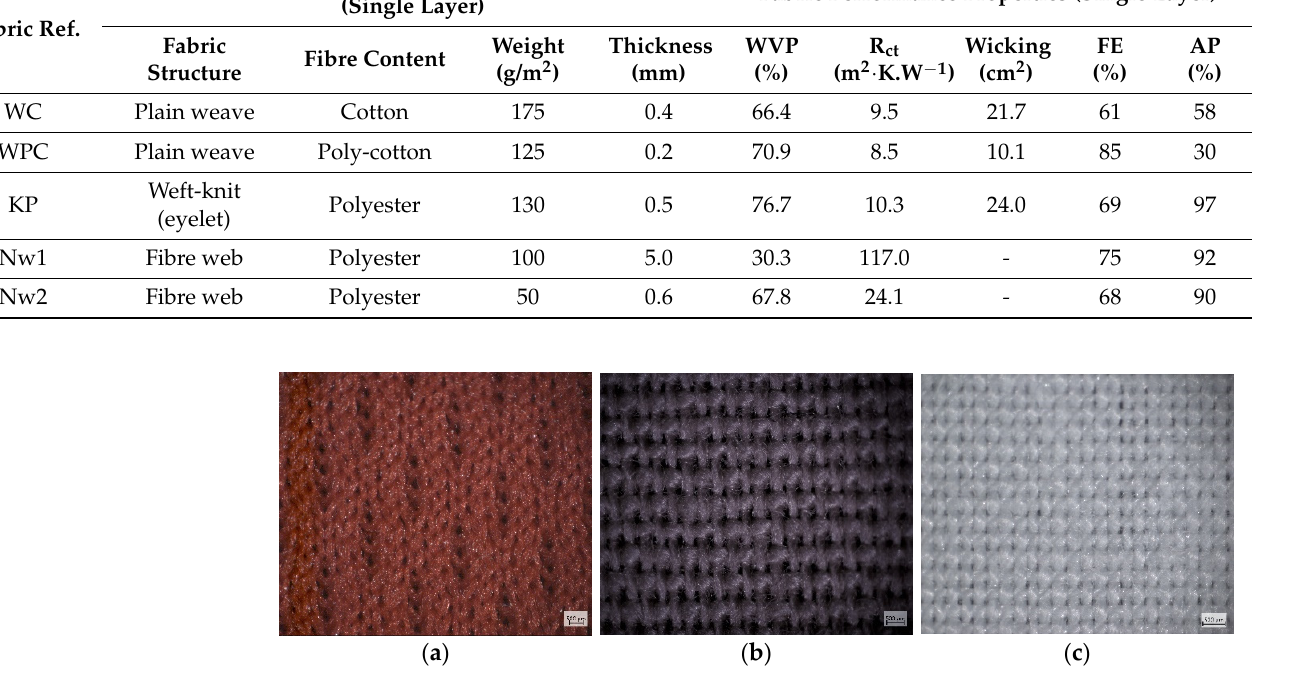
Figure 1. Illustration of mask styles. ( a ) Shaped mask (style S); ( b ) pleated mask (style E); ( c ) mask with filter (style EF).